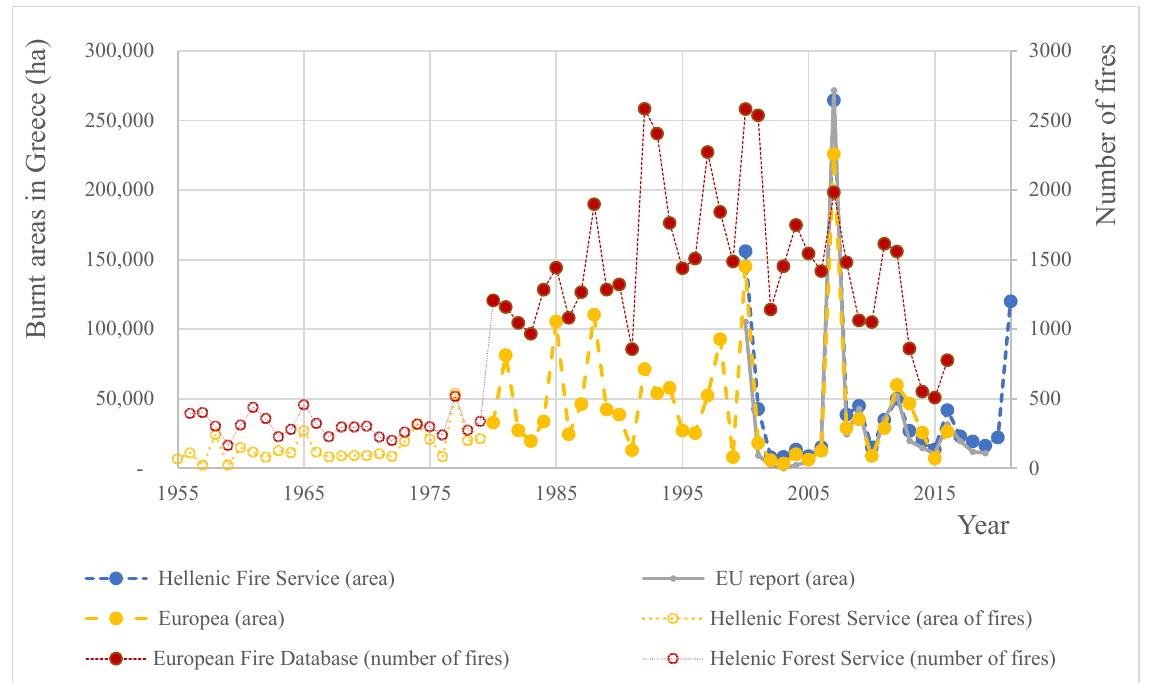
Figure 4. The evolution of wildfires in Greece (1980–2021). Data before 1980 are impacted by larger uncertainty (lack of satellite vision) and are depicted in gray.